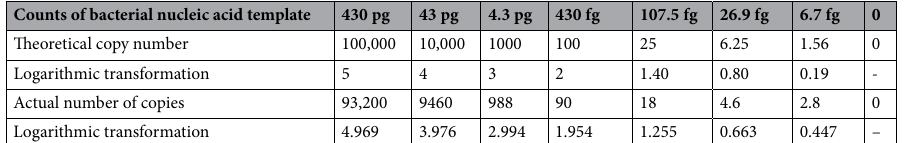
Counts of bacterial nucleic acid template